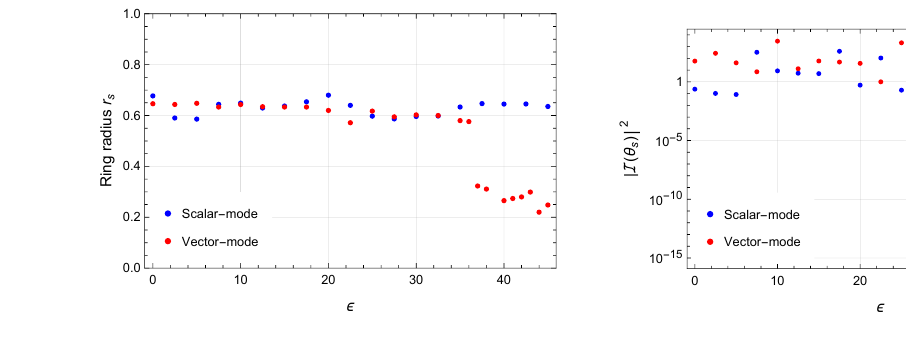
Figure 16 . The (cid:15) dependence of a ring ra- dius in the image. Blue points and red points correspond to a scalar-mode and a vector- mode perturbation respectively.